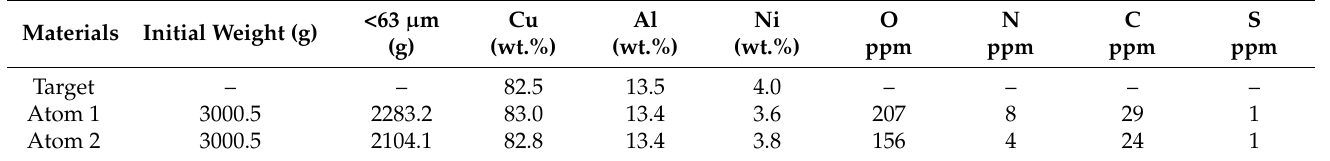
Table 1. Obtained weights and chemical composition, measured by ICP and LECO, for the different gas atomization of the same Cu–Al–Ni alloy.